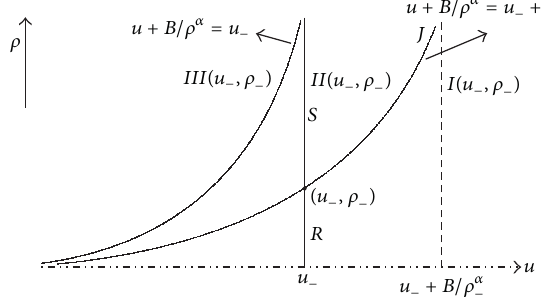
Figure 1: Phase plane and elementary wave